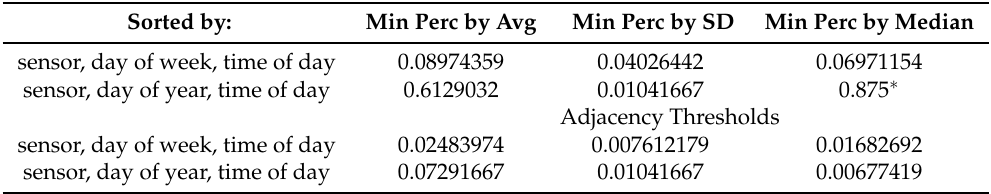
Table 14. Thresholds used for classifying windows by percentile scores in Phase 2. * indicates the largest threshold, τ 1 .